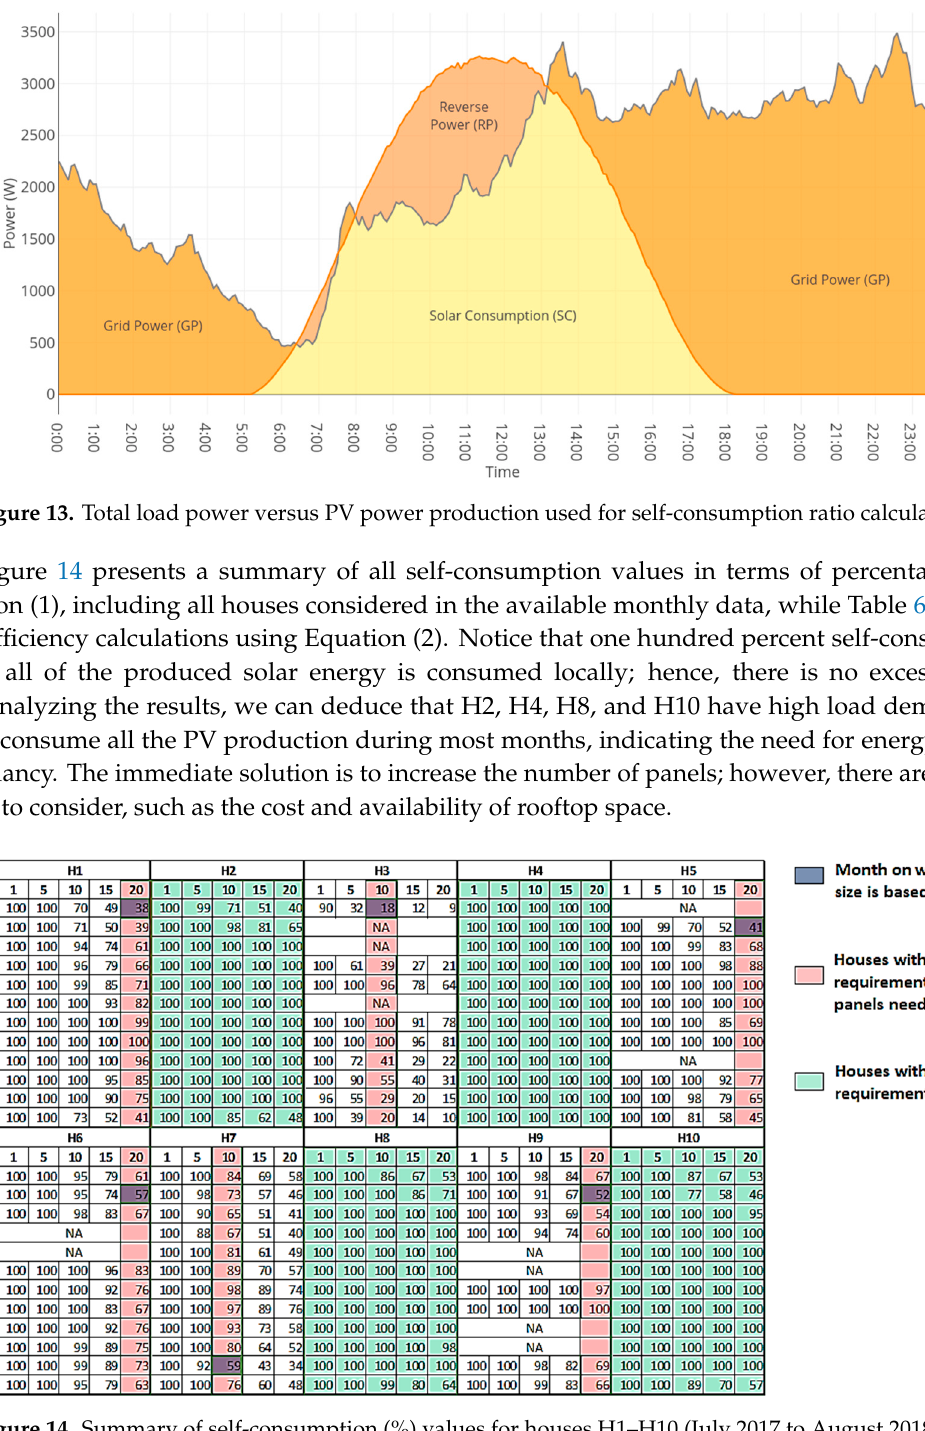
Figure 14. Summary of self-consumption (%) values for houses H1–H10 (July 2017 to August 2018) for five different PV sizes. Table 6. Self-sufficiency: percentage (%) of energy offset by PV consumption.